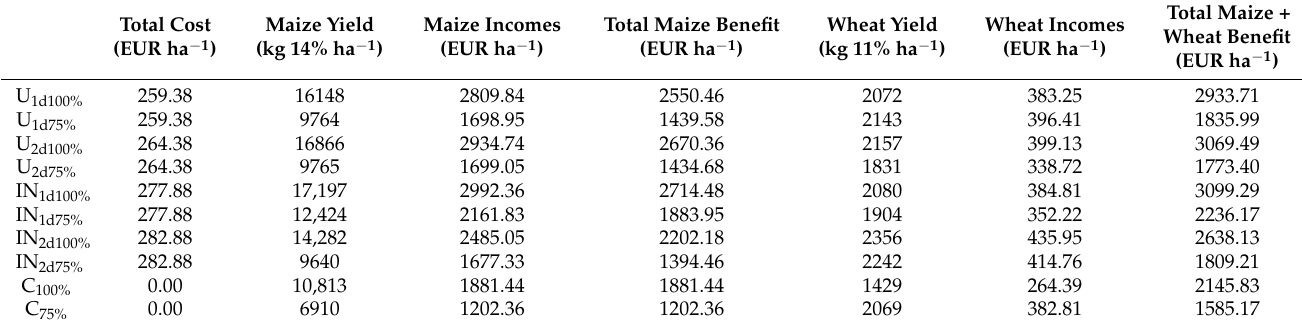
Table 5. Economic analysis. Treatments were a combination of urease inhibitor use (In), simple urea use (U), or no fertilizer (C), with fertilizer application in one (1 d) or two (2 d) dressings and optimally irrigated (100%) or sub-optimally irrigated